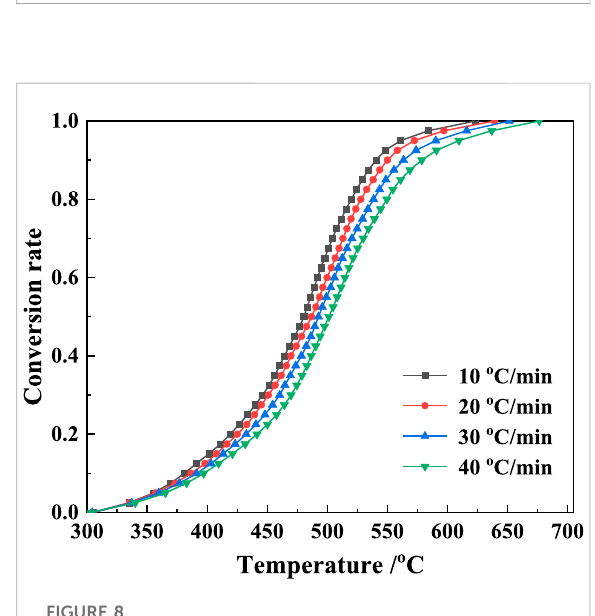
FIGURE 7 Release fl ow of gas products.